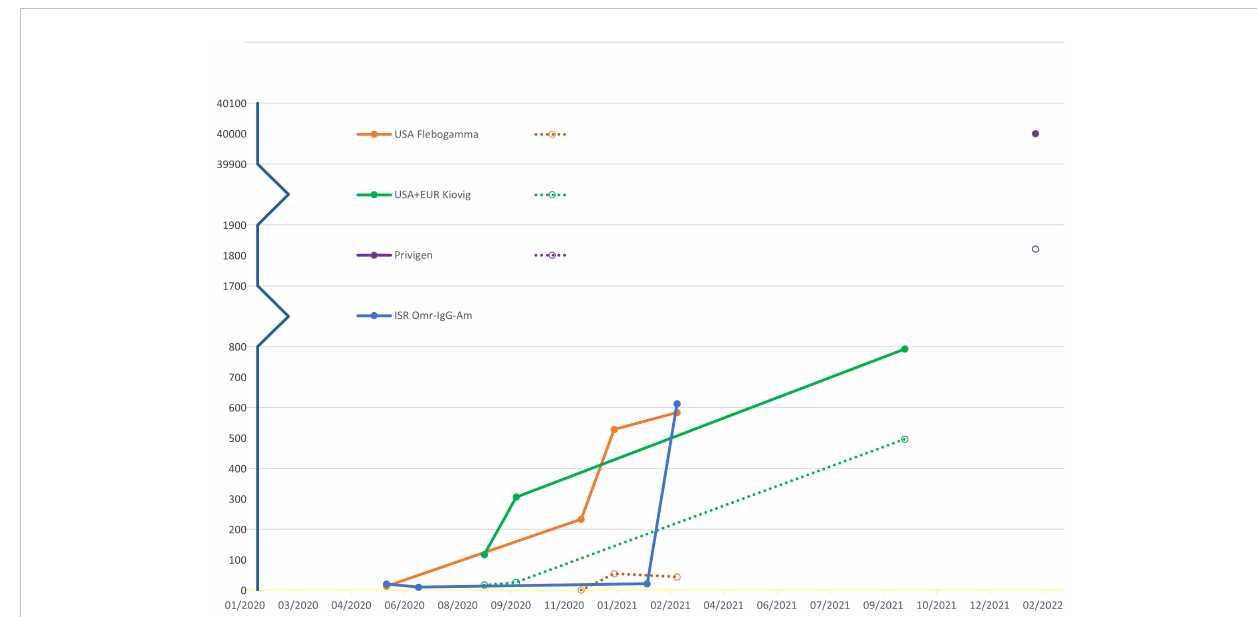
FIGURE 2 Average SARS-CoV2-spike antibody titer levels measured in AU/mL over time Different commercial products (solid lines), XLA patients ’ sera (dotted